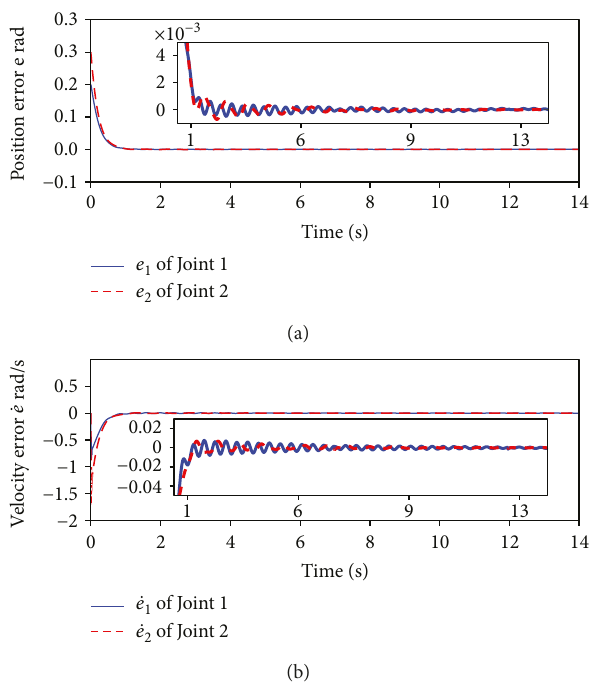
Figure 9: Tracking error of the proposed adaptive law with bounded exogenous